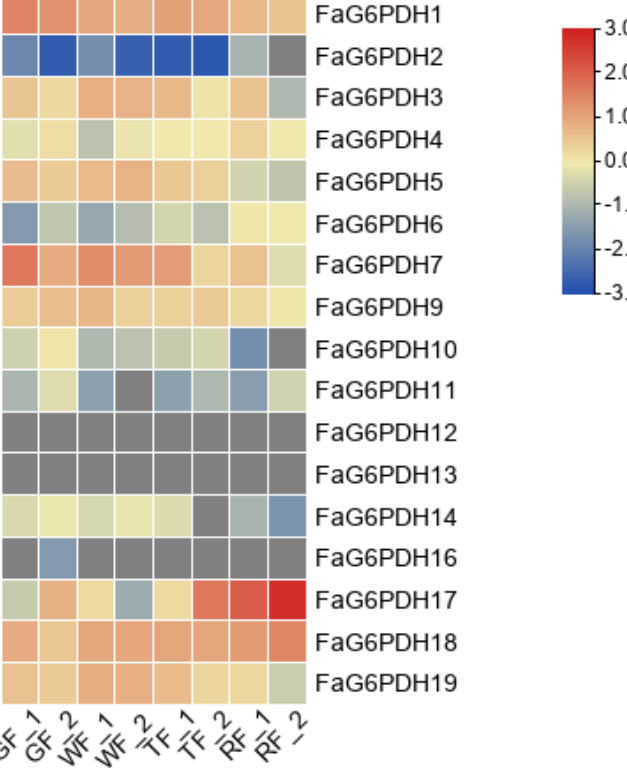
Figure 6. Heat map of FaG6PDH expression at different fruit development stages. qRTPCR data were normalized using Actin. GF: green fruit; WF: white fruit; TF: turning fruit; RF: red fruit.